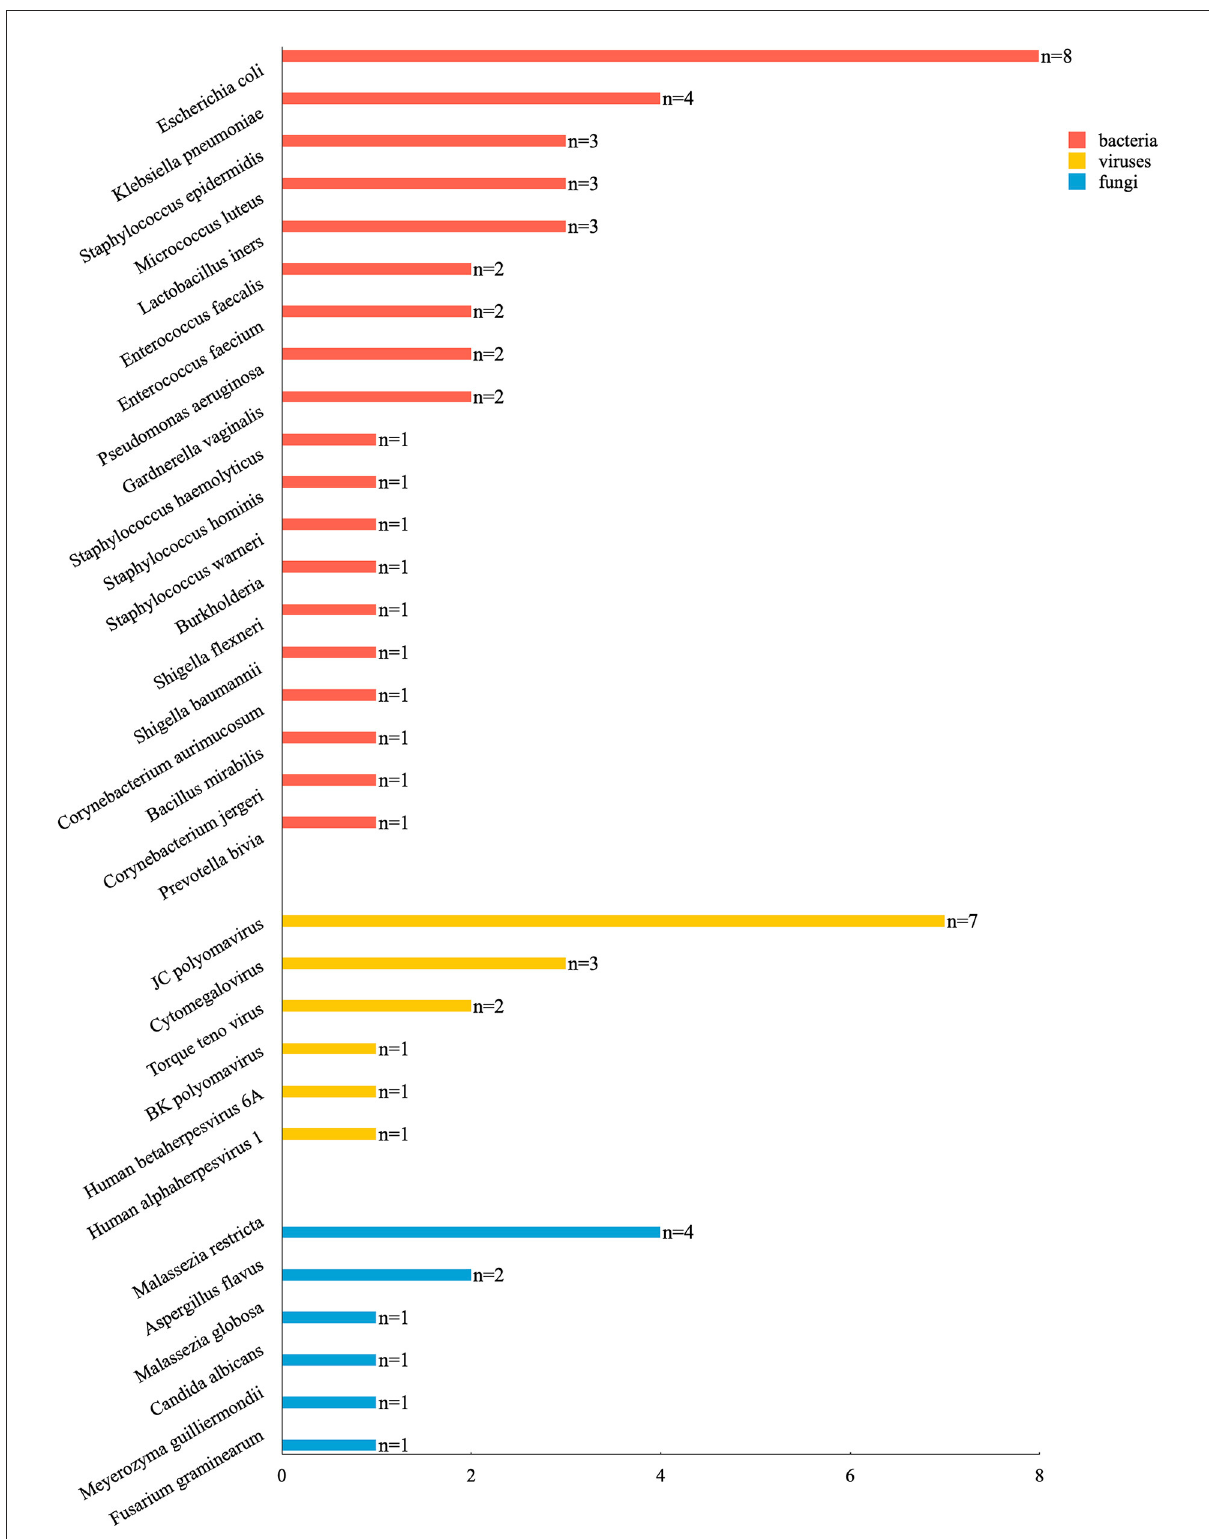
FIGURE2 The category of pathogenic microorganisms detected by mNGS and the corresponding numbers of patients.